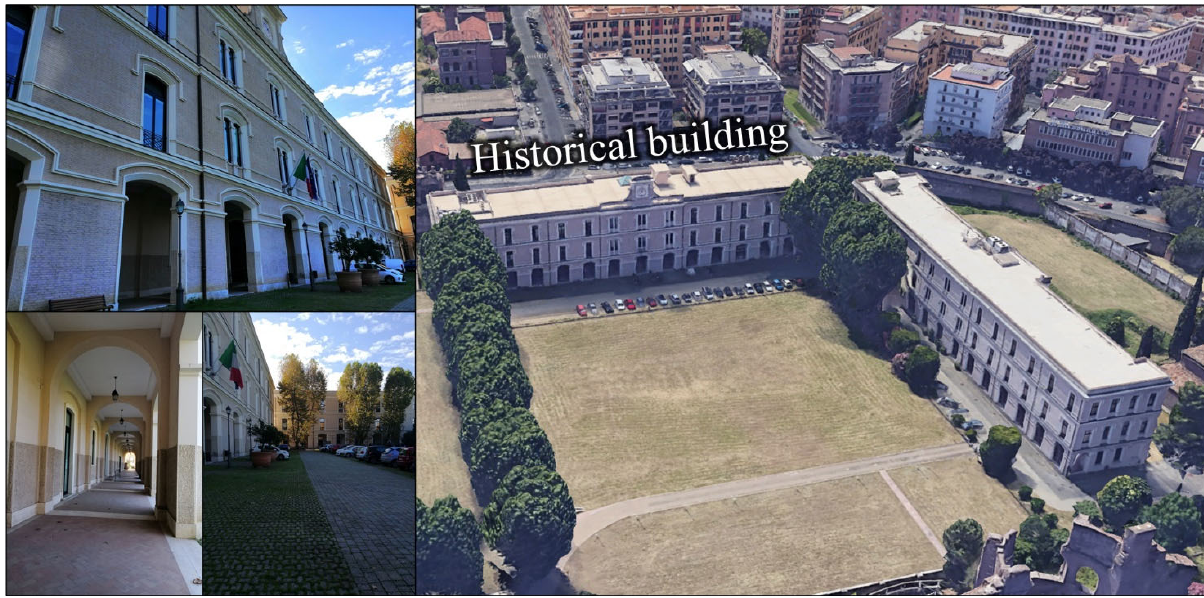
Figure 2. Three ‐ dimensional view of the historical building.